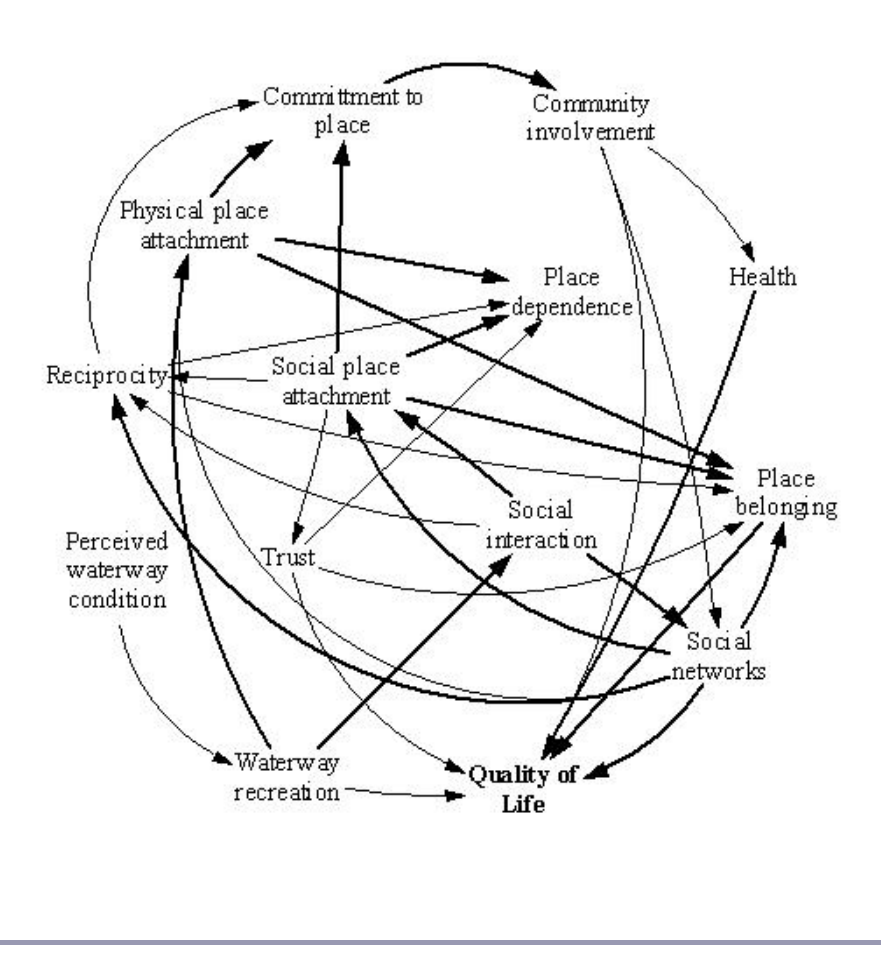
Fig. 4. Significant paths between perceived waterway condition and quality of life in the Douglas region. Paths in bold are common to both study